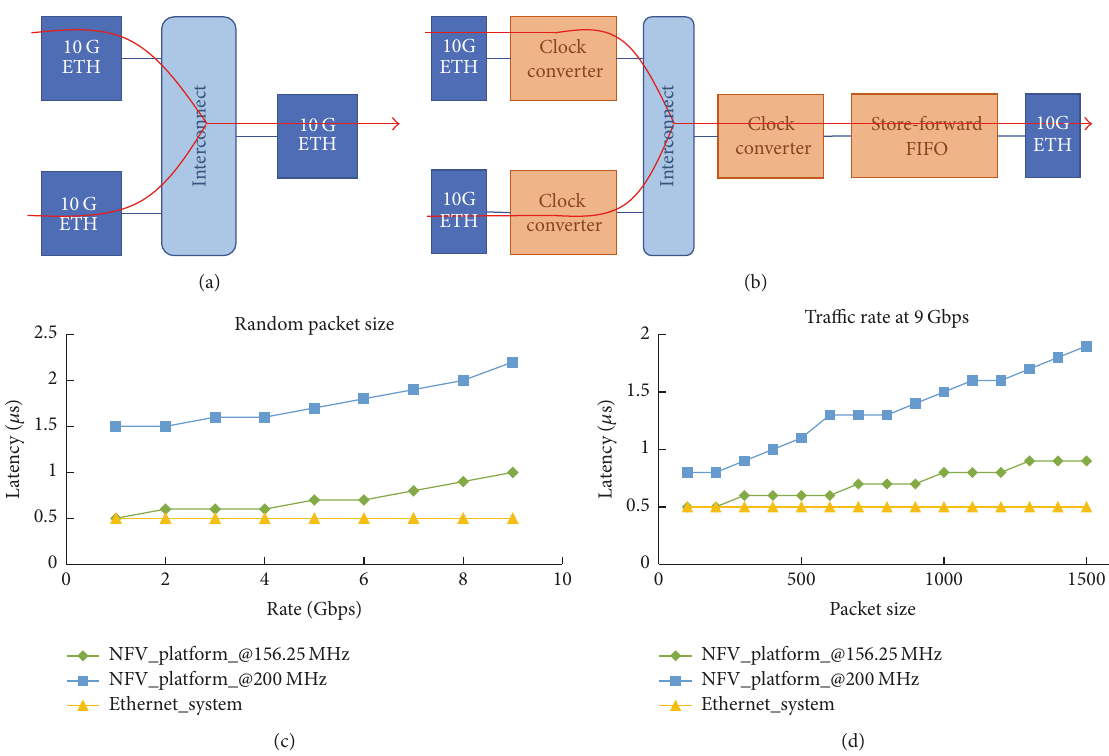
Figure 11: The experiment was set up at 156.25 MHz (a) and 200 MHz (b). And the latency under different data rate (c) and Ethernet packet size